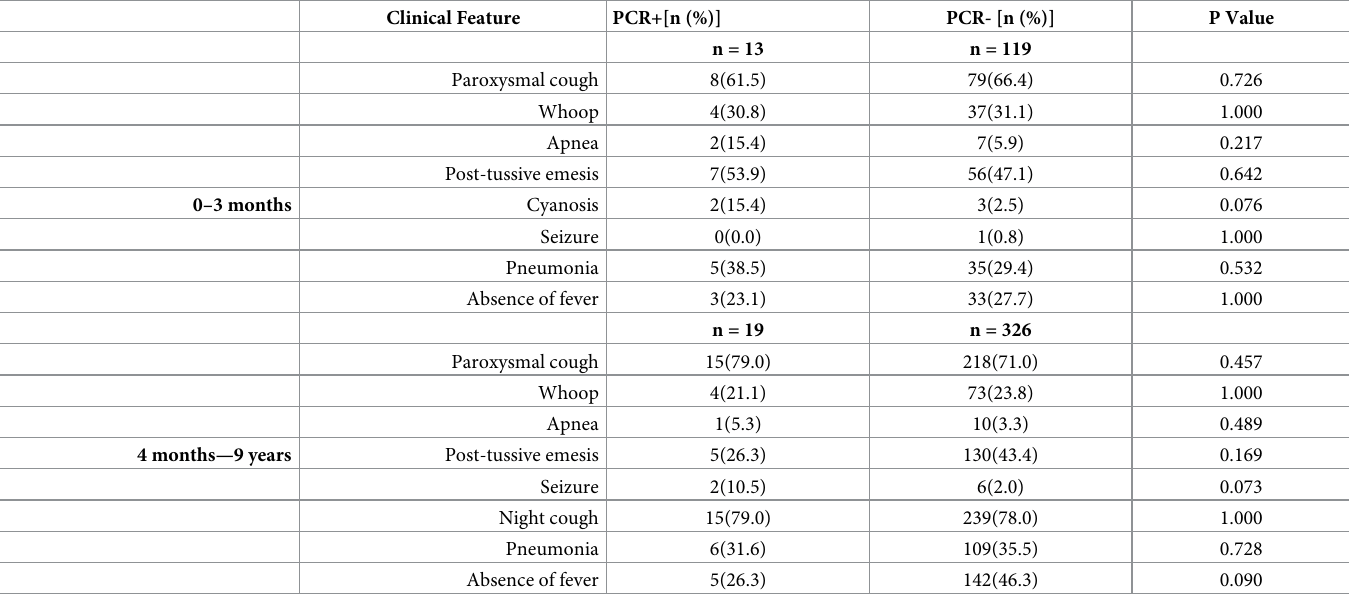
respectively) while inspiratory whoop gave the highest specificity (68.9% % 0 to 3 months and 76.2% 4 months to 9 years, respectively) of any single feature on its own, Fig 1. Overall, when the whole group was considered, the use of any feature suggested by WHO had sensitivity of Table 3. Clinical presentation of children by Bordetella pertussis PCR status N =